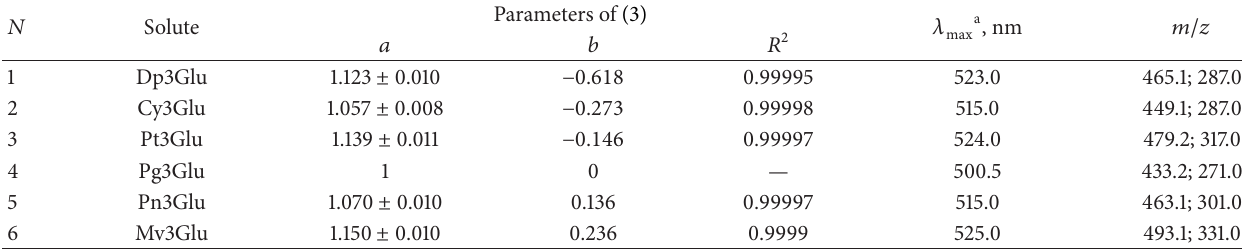
Table 1: Chromatographic characteristics of 3 glucosides of six common anthocyanidins.